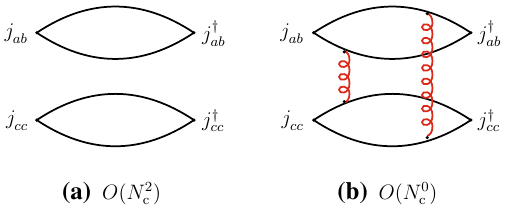
Fig. 9 Leading- and subleading-order diagrams of the direct channel II of Eq. (3.1)